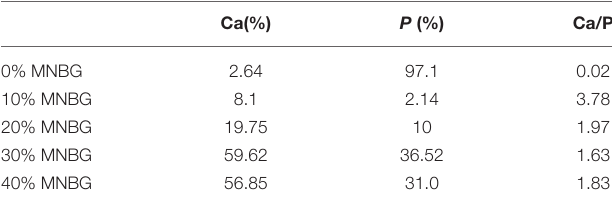
TABLE 1 | The ratio of Ca to P after scaffolds immersion in SBF for 3 days. Ca(%) P (%) Ca/P